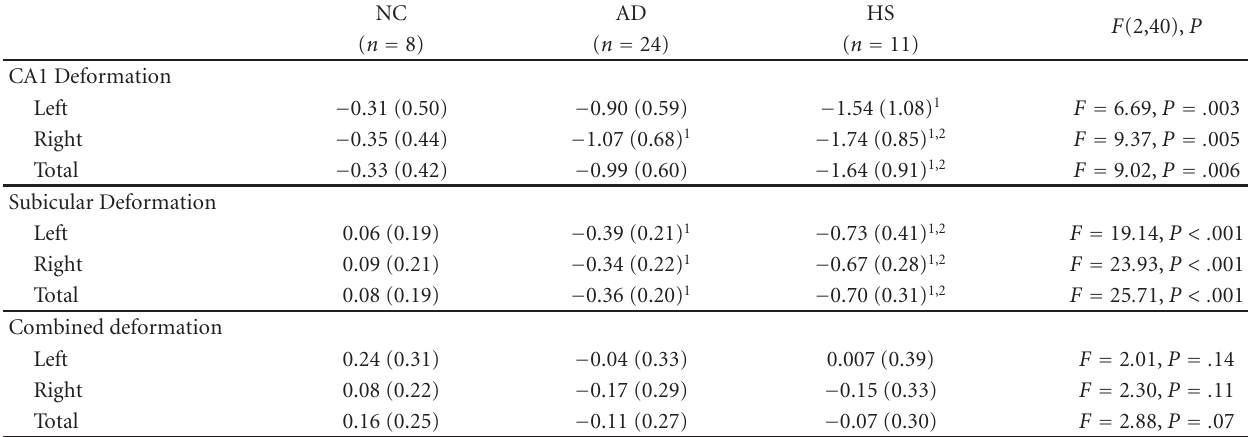
Table 4: Hippocampal shape deformations expressed as z -scores.